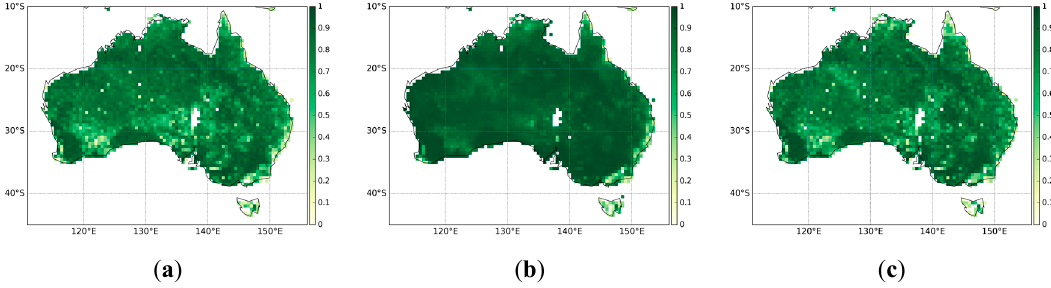
Figure 3. The Pearson correlation coefficient among the FAPAR datasets for the years 2001–2015: ( a ) MODIS against QA4ECV, ( b ) MODIS against CGLS, ( c ) QA4ECV against CGLS.